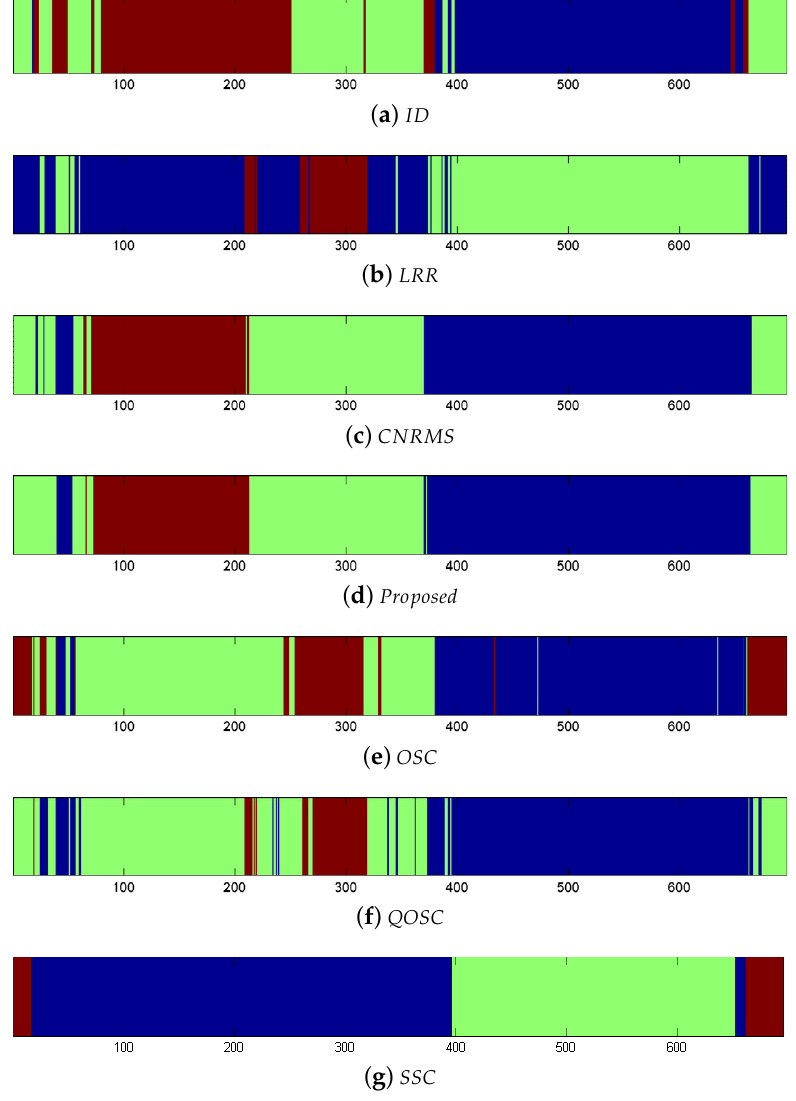
Figure 6. Clustering results of “ p 3 − meet −